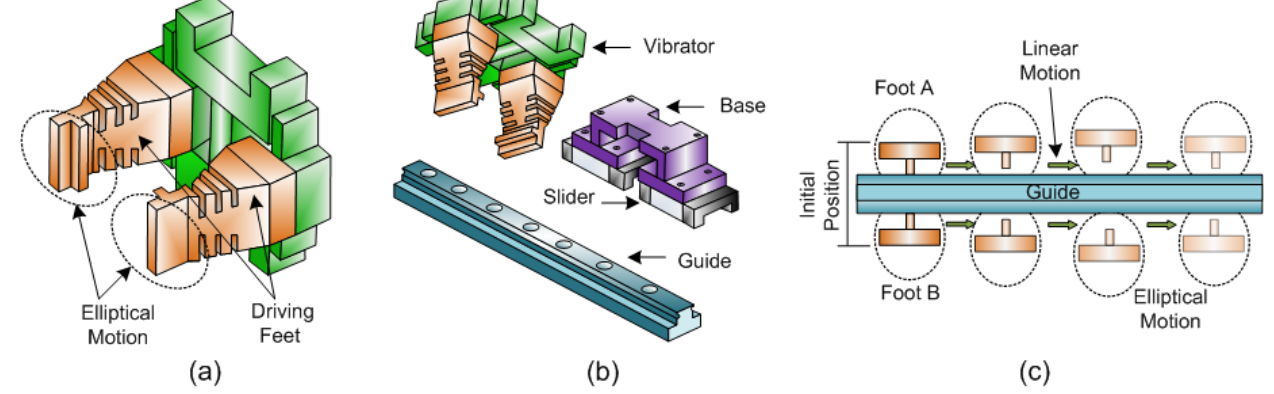
Figure 8. Linear piezo-actuators functioning in solar cleaning applications; ( a ) elliptical motion of their feet, ( b ) the driving bar and the support, and ( c ) the elliptical motion and linear motion for both the driving feet